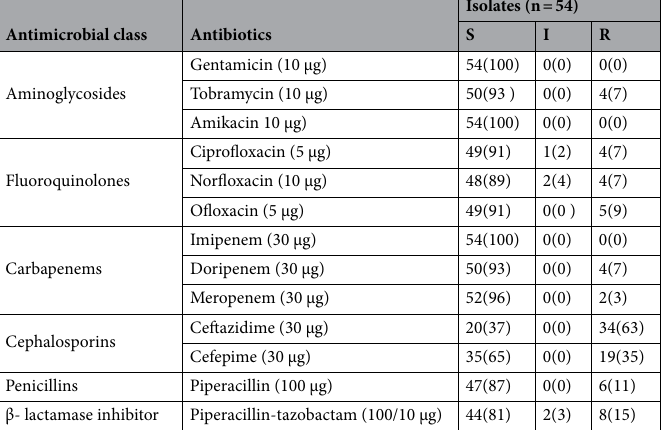
Table 2. Distribution of the Antimicrobial Susceptibility Pattern of P. aeruginosa isolates. R: Resistant, S: Sensitive, I: Intermediate, n: Number of isolates, the parenthesis value denotes percentage (%).